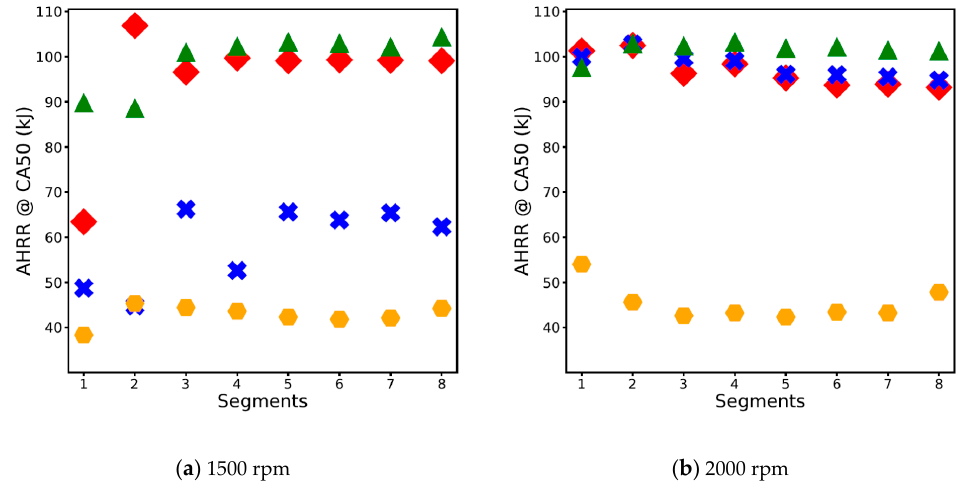
Figure 15. AHRR at all loads in each stage at ( a ) 1500 rpm and ( b ) 2000 rpm. The red thick diamond represents 100% load, the blue thick cross 50% load, the green triangle 75% load and the orange hexagon 25% load.